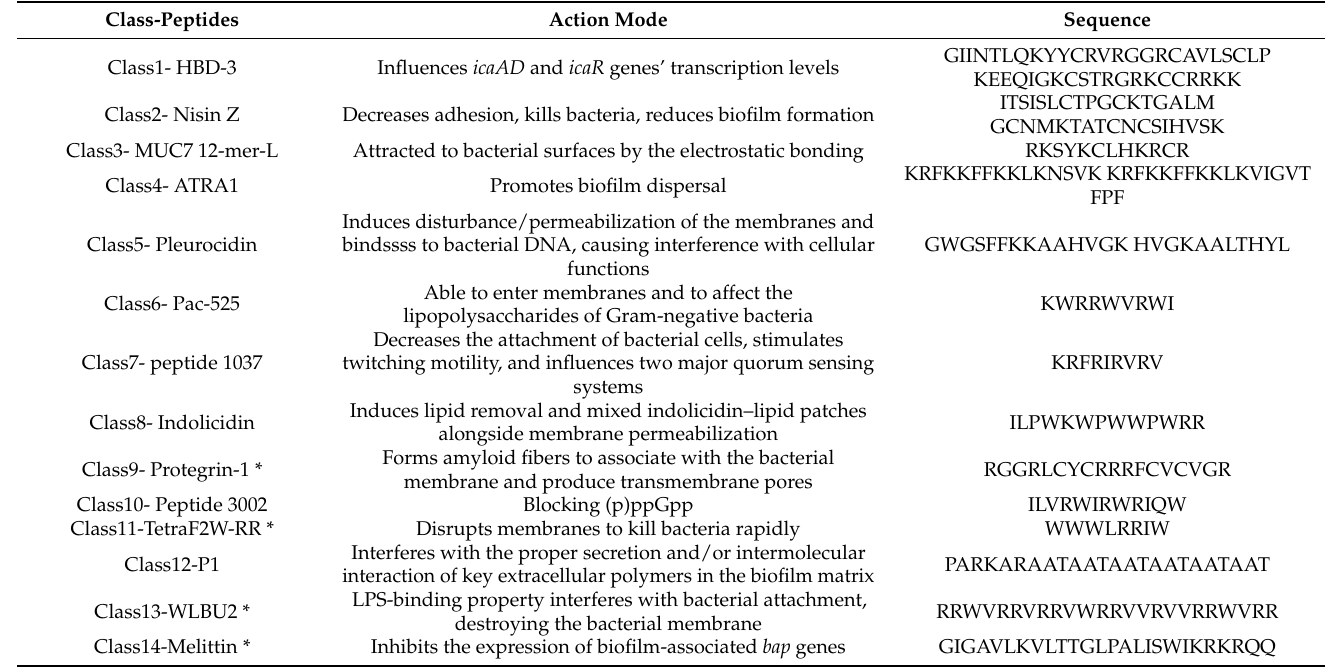
Table 4. Representative ABFPs categorized in 14 classes according to the mechanisms of action elucidated for their antibiofilm activity. The information displayed in this table was gathered from Table S2 published in ref.